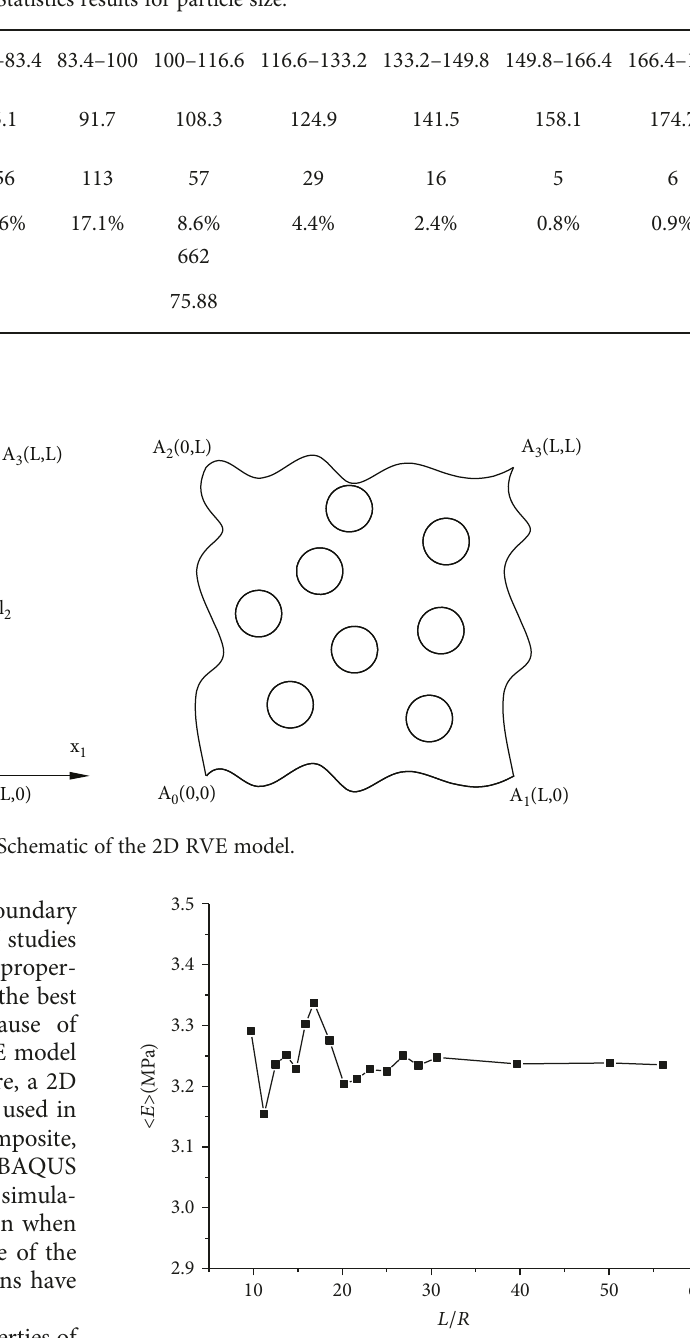
Figure 5: Equivalent elastic modulus < E > values of NSBR rubber composites ( V f = 10% ) with di ff erent L / R